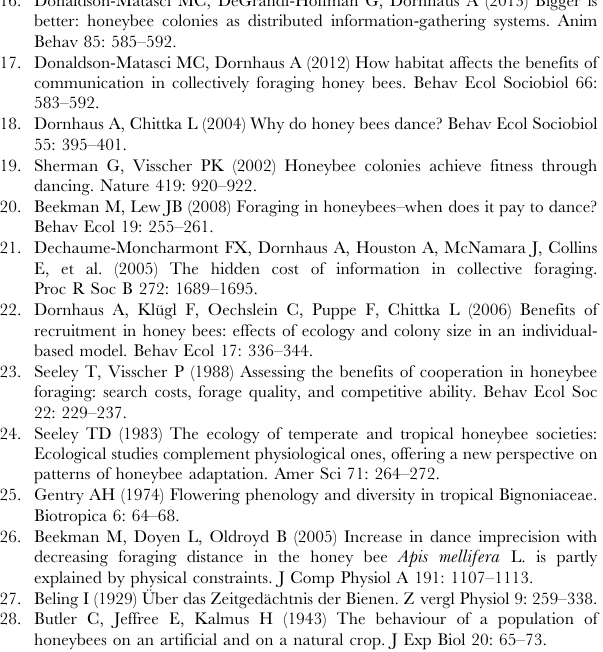
Figure S2 The probability of an agent to dance after a foraging trip in response to the influx of returned foragers. When more foragers return they are less likely to dance. We modelled this as a linear decrease of the probability to dance up to 20 foragers, at which level the dance probability remained constant. Figure S3 The effect of patch longevity on foragers’ persistence to remain with a foraging patch. The longer patches yield energy, the longer a forager stays with a patch to which it is committed (except for the patch longevity all parameters were set to the default values given in table 1 of the main text). Figure S4 The effect of population size on the foraging success measured as mean daily gain in honey (means 6 s.e.) with spatial information transfer (SI) or no spatial information transfer (NI). At all population sizes ( a) N = 300; b) N = 600; c) N = 1200) the switching between SI and NI treatments masks the benefit of SI (solid circle: SI, open circles: NI). Figure S5 The effect of the Le´vy flight parameter m Le´vi on the foraging success measured as mean daily gain in honey (means 6